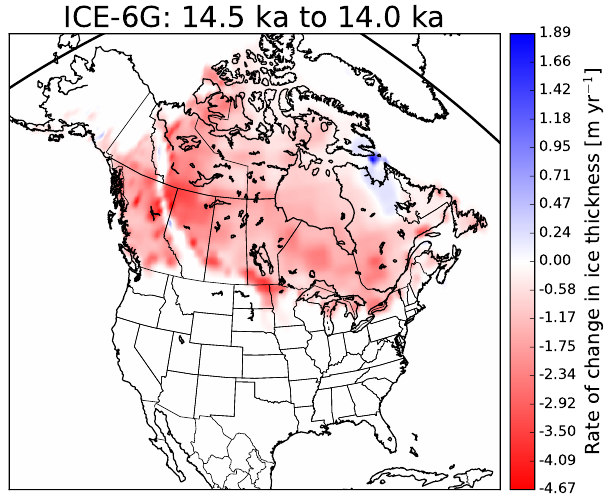
Figure 4. Ice-surface mass balance. Ice-sheet mass balance is a ma- jor, and often dominant, input to calculations of North American river discharge during deglaciation (Eq.